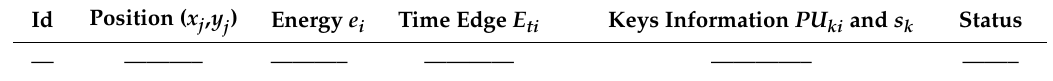
Table 1. Structure of the generalized